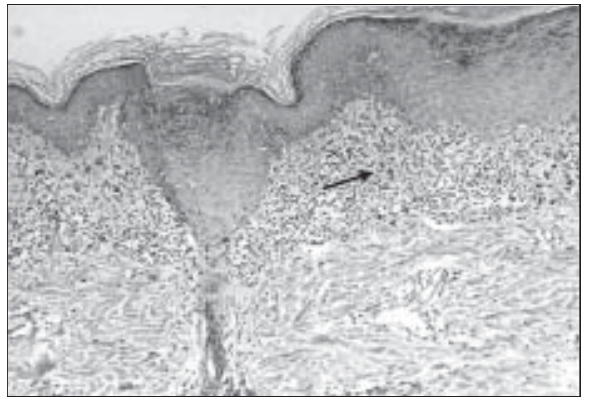
Figura 4 – Líquen plano cutâneo. Hiperceratose lamelar, hipergranulose em cunha correspondendo ao acrossiríngio, infiltrado inflamatório superficial em faixa, melanófagos (seta) (HE, aumento original 100x)